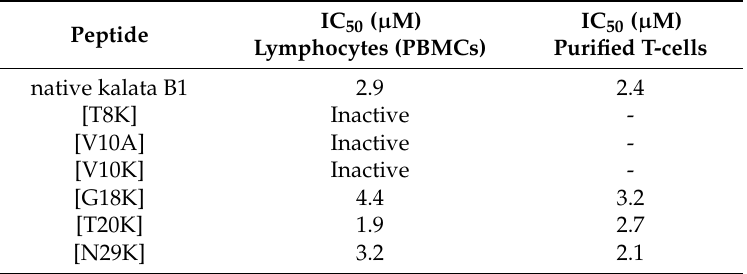
Table 6. IC 50 of kalata B1 and derived peptides in lymphocytes and purified T-cells, PBMC: Peripheral Blood Mononuclear